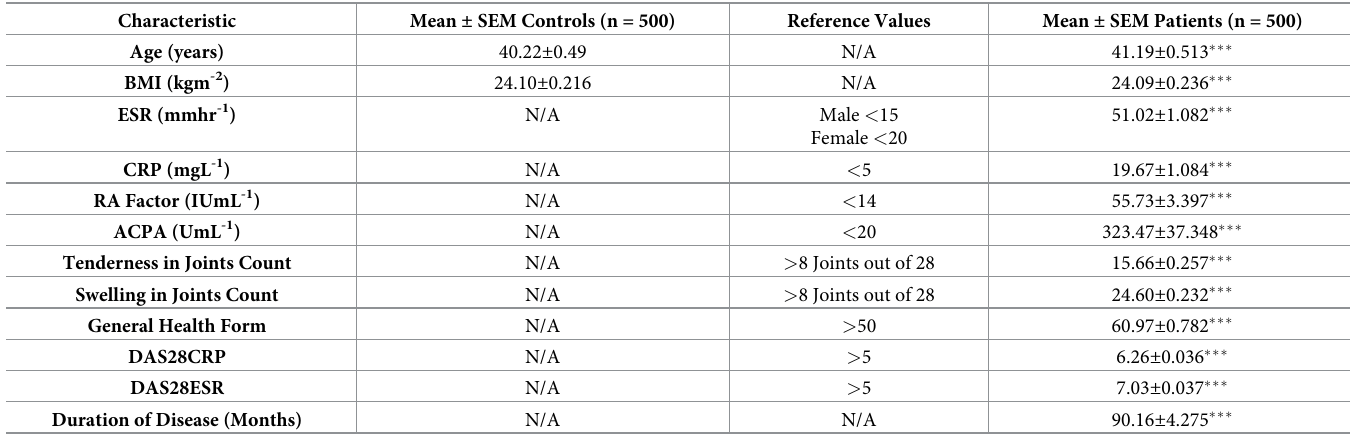
Table 1. Patients’ demographic data.